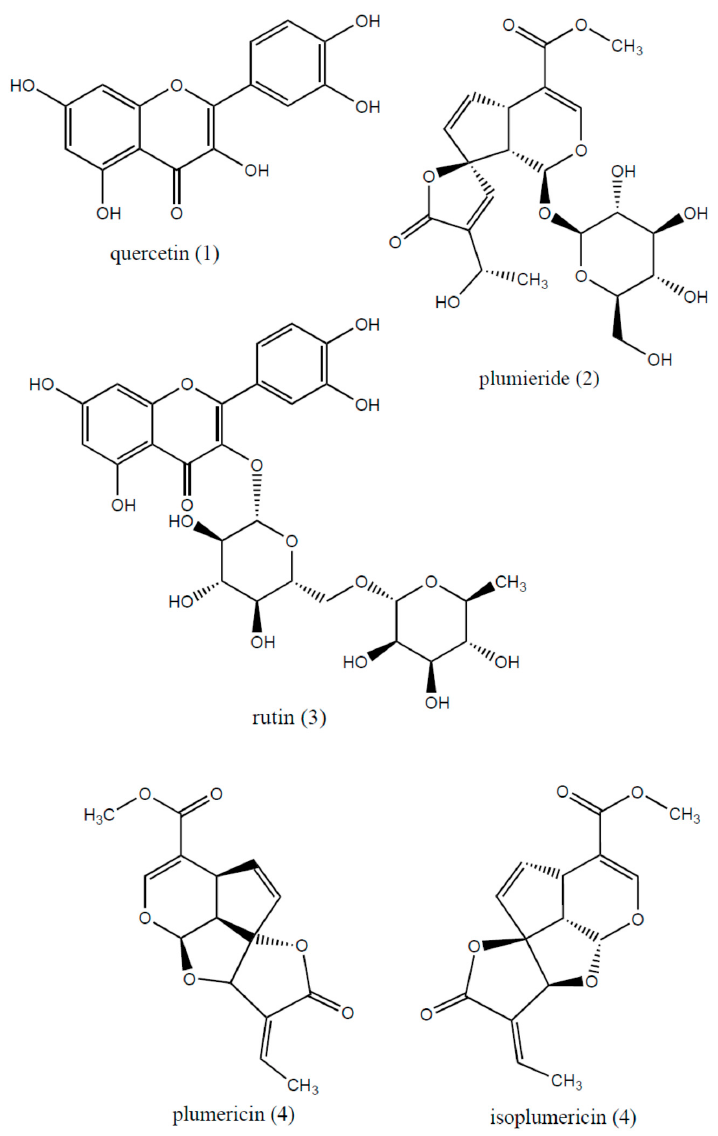
Figure 5. Chemical structure of compounds identified by HPLC-ESI-MS in hydroalcoholic extract from leaves of Himatanthus drasticus .